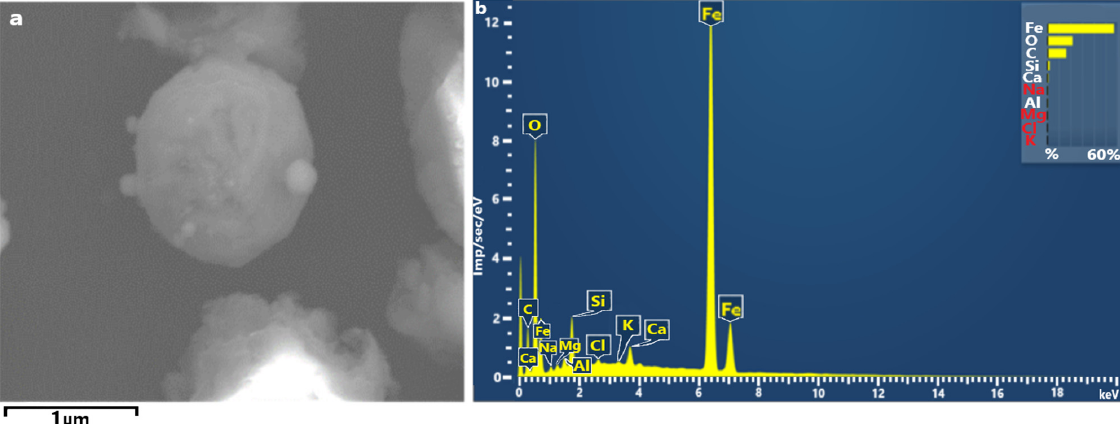
Exposure to PM 2.5 bound metal(loid)s may pose serious carcinogenic or non-carcino- genic toxicity in humans depending on various factors such as exposure concentration, duration, and frequency. Health risk assessments of TEs through the inhalation pathway for both children and adult were determined, and the values of HQinh and HI are reported in Table 5. It was observed that the non-carcinogenic risk for each individual TE was well below the safe level ( HQinh = 1) for both groups (adults and children), except HQinh (Mn) value for children at Stations 2 and 3. It was higher than 1 for stations located near metallurgical plants. Exposure to all other TEs through inhalation was within safe limits for all stations. The HQinh of all studied TEs indicated a greater hazard to children than adults. Table 5 shows that HI values were lower than 1 for adults but risks for children were significant. The greatest danger was posed by metallurgical industrial PM emissions containing Mn. Table 5. The values of hazard quotient ( HQinh ) for children and adults in various stations. TE